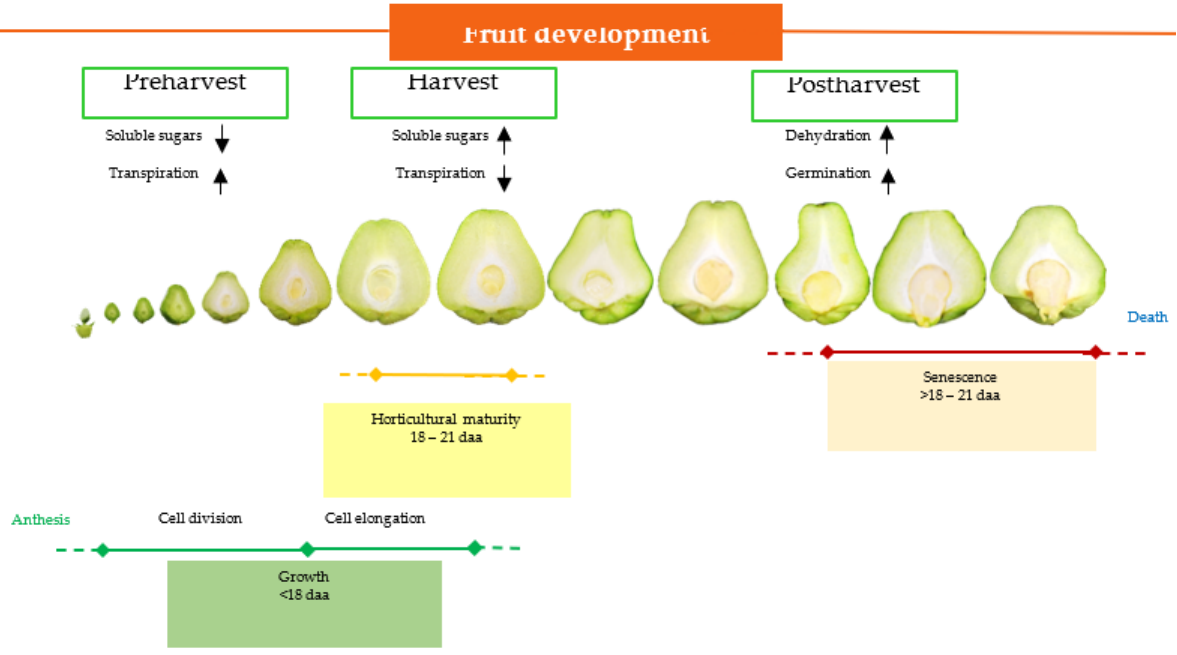
Figure 8 . Physiological phases of fruit development of chayote Sechium edule var. virens levis . Solid lines indicate intensity ( ) and dashed lines indicate weakness (---); the arrow indicates high values and the arrow indicates low values. 3. Materials and Methods